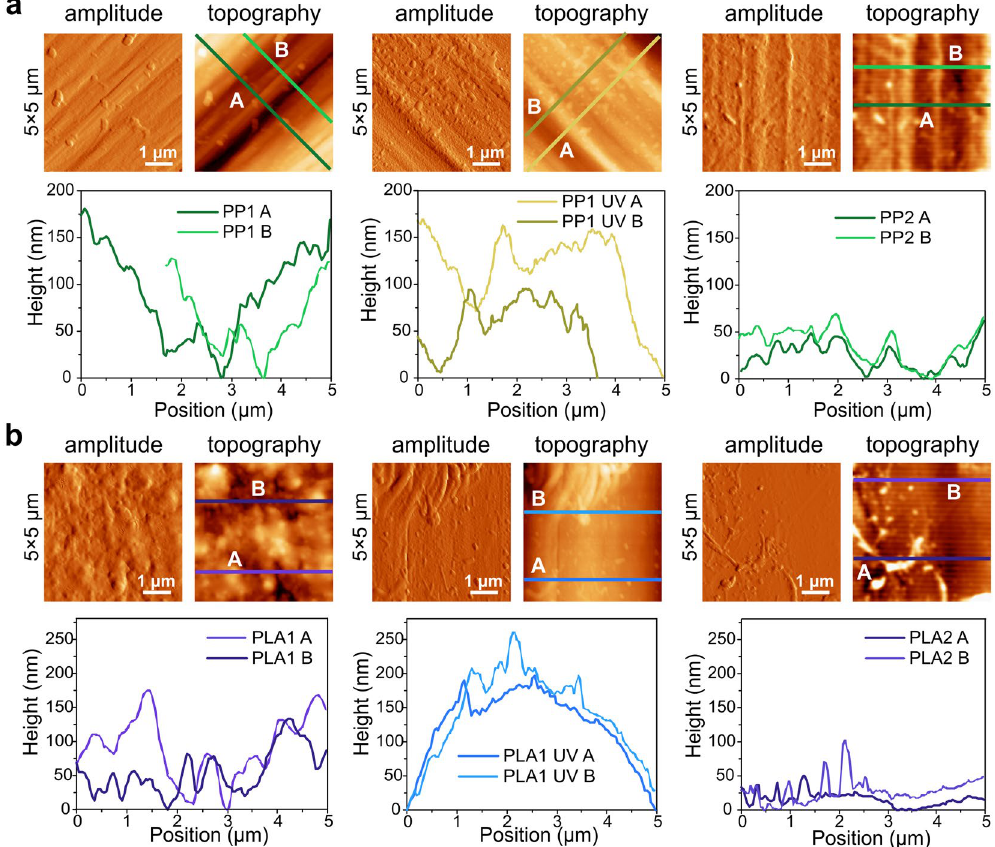
Figure 2. AFM amplitude and topography 5 × 5 μ m images of ( a ) PP fibres before coating: PP1 (left); UVO- treated PP1 (middle); PP2 (right) and corresponding height profiles of transverse lines with respect to the extrusion axis (bottom); and ( b ) PLA fibres before coating: PLA1 (left); UVO-treated PLA1 (middle); PLA2 (right) and corresponding height profiles of transverse lines with respect to the extrusion axis (bottom). All height profiles were taken at 45° with respect to the extrusion